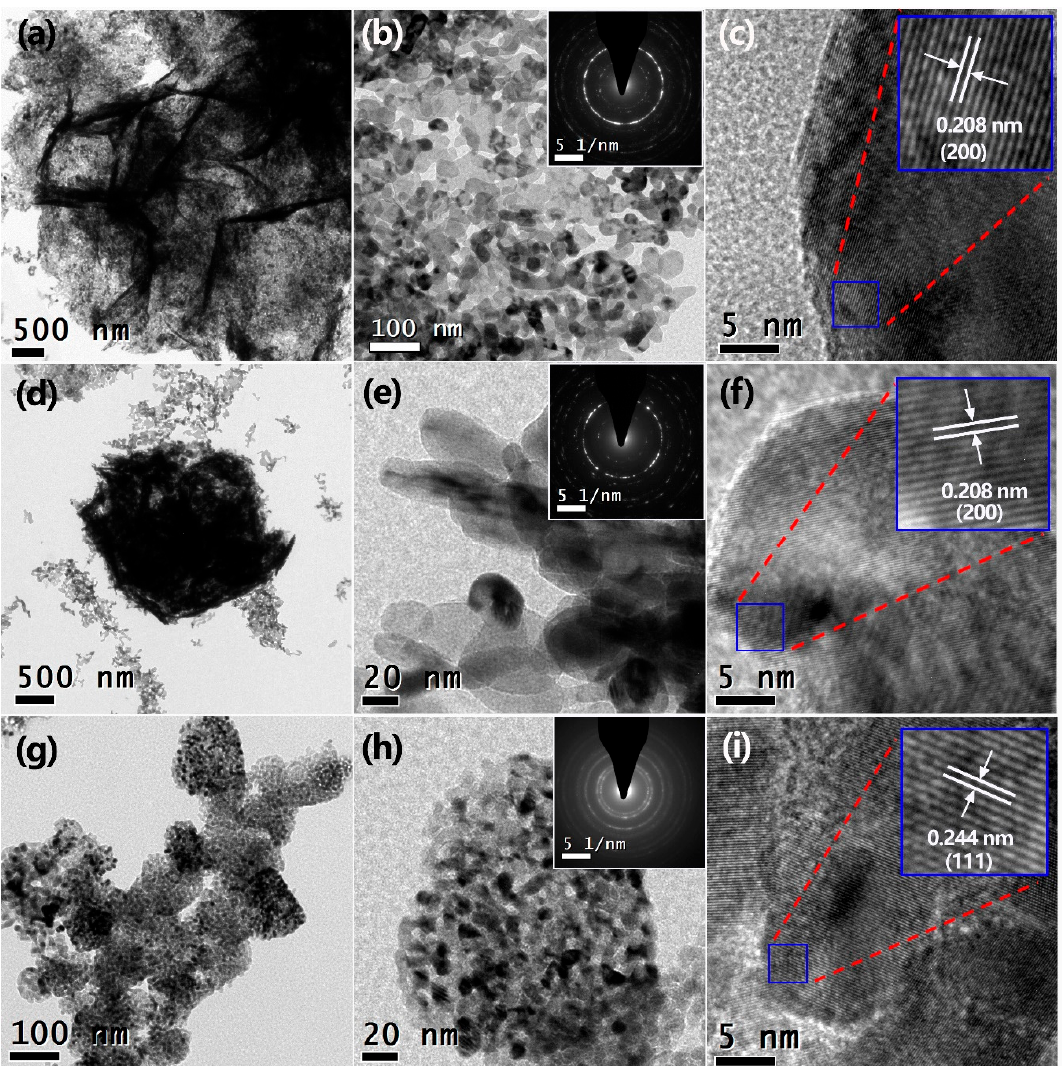
Figure 3. TEM and HRTEM images of as-prepared NiO nanostructures: ( a ) low-magnification TEM image, ( b ) high-magnification TEM image, and ( c ) HRTEM image of NiO nanosheet; ( d ) low-magnification TEM image, ( e ) high-magnification TEM image, and ( f ) HRTEM image of NiO microspheres; ( g ) low-magnification TEM image, ( h ) high-magnification TEM image, and ( i ) HRTEM image of NiO sub-microsphere. The insets in ( b ), ( e ), and ( h ) show the corresponding selected area electron diffraction (SAED) patterns.